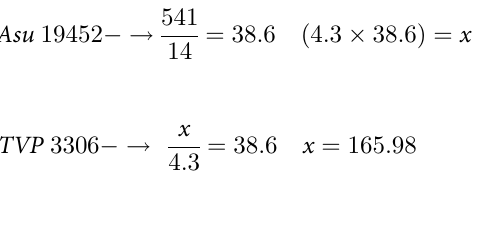
The quadrate of specimen ASU 19452 was measured, and the quadrate-to-SVL ratio was then used to calculate the SVL for the rest of the specimens (Table 1). A total of 12 elements were studied and described, only using the right of paired elements, following the terminology used in Cundall and Irish [19] and Evans [22]. Abbreviations from Cundall and Irish [19] were followed. When not available in Cundall and Irish [19] abbreviations from Evans [22] were followed. When neither were available abbreviations were created. The chosen reference specimen (ETVP 3295) was then compared to other age ranks in order to record any ontoge- netic changes. Reference specimen was chosen due to it being the largest specimen and there- fore, the presumed most mature.